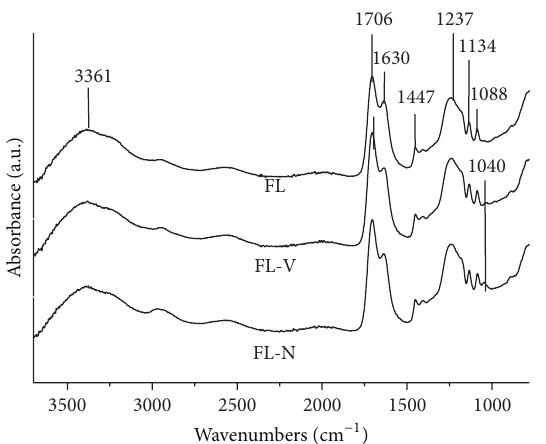
Figure 2: FTIR spectra of Fuji-IX liquid (FL) and solutions formed after dispersion of 2 wt% PGV and PGN nanoclays in FL.